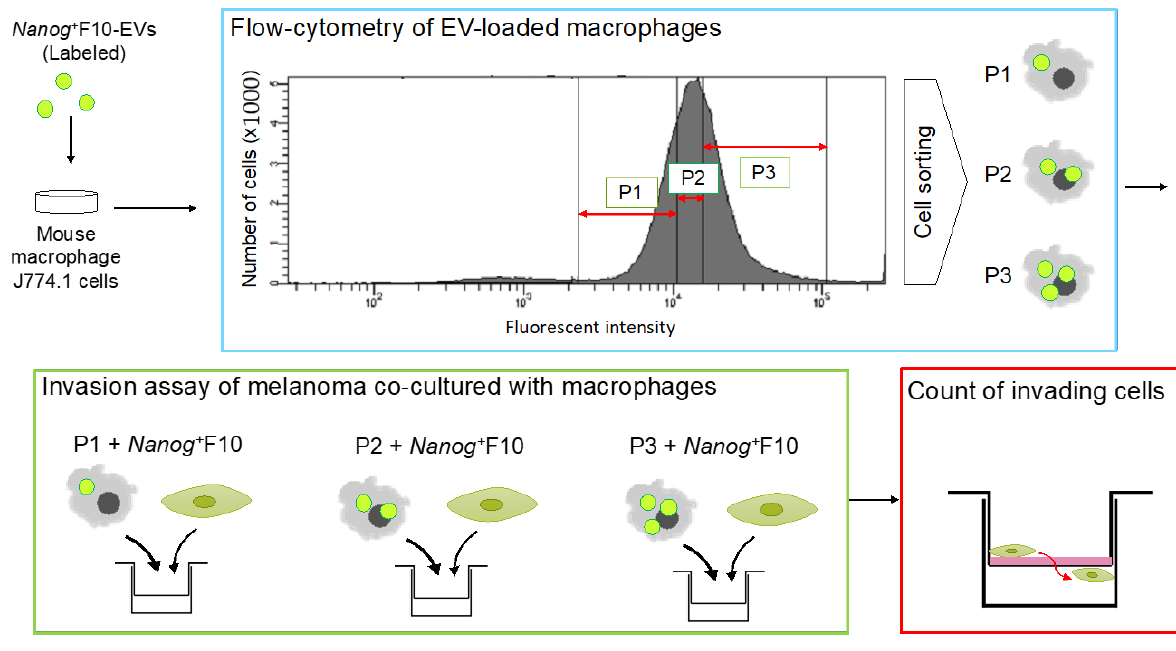
Figure 6. Experimental protocol to analyze the effects of EV-uptake quantity on the invasion ability of macrophages. EVs are labeled with a fluorescent probe. J774.1 cells are fractionated, with a cell sorter, into P1, P2, and P3 fractions, respectively, according to the intensities of fluorescence of EVs. Each fraction of J774.1 cells is co-cultured with Nanog + F10 cells and tested for invasion ability with Transwell ® invasion assay kits. The number of melanoma cells that invade the Transwell membrane are